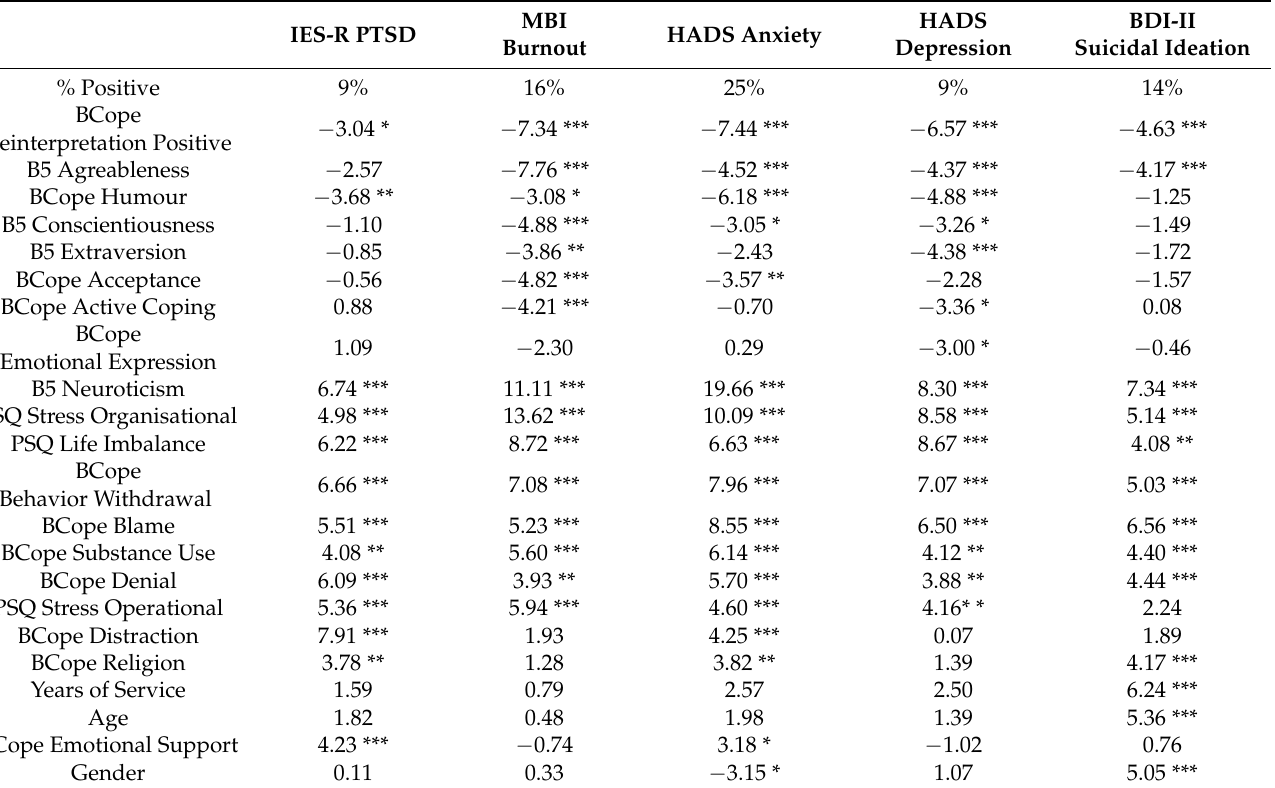
Table 2. Two-sample t -tests (presence vs. absence) for pathologies PTSD, Burnout, Suicidal Ideation, Anxiety and Depression (test statistic values and * p < 0.05; ** p < 0.01; *** p < 0.001 after Holm- Bonferroni correction). Above the first horizontal line, the pathological group had weaker values